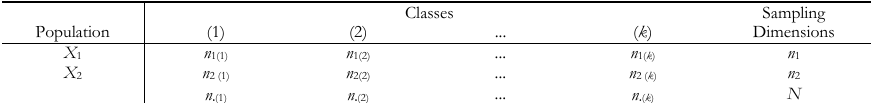
Probabilities ordered by frequencies Classes Sampling